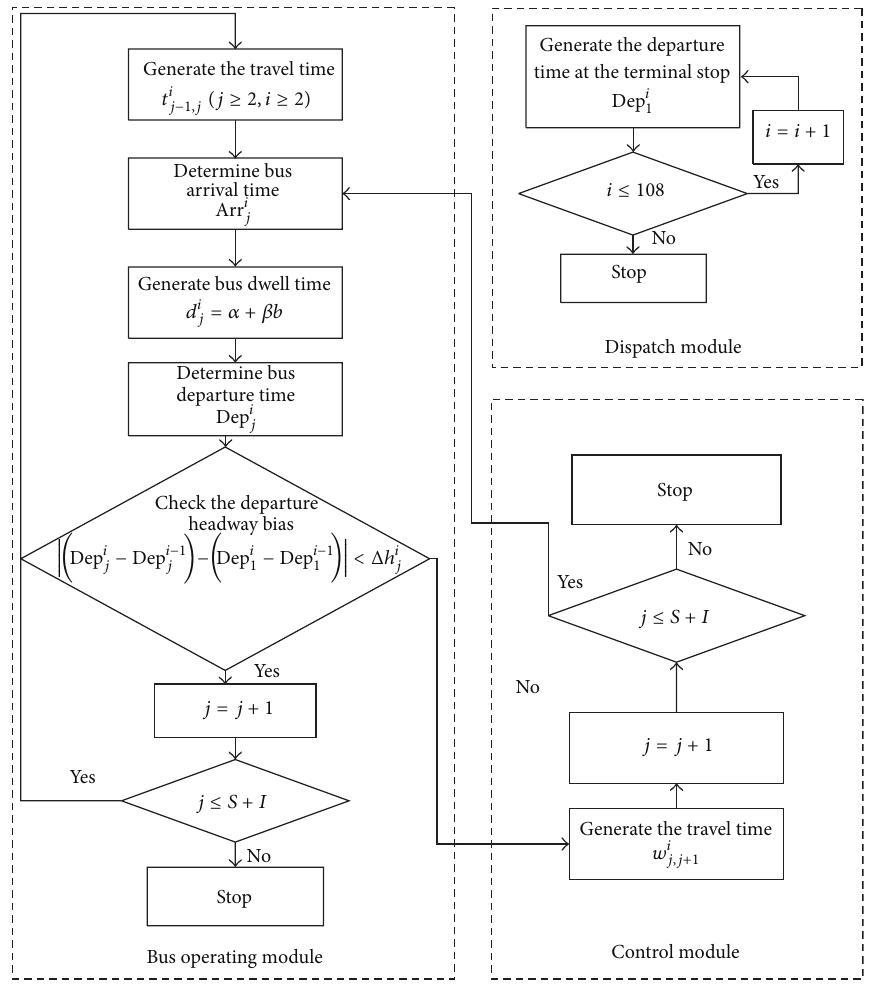
Figure 6: Flowchart of transit simulation